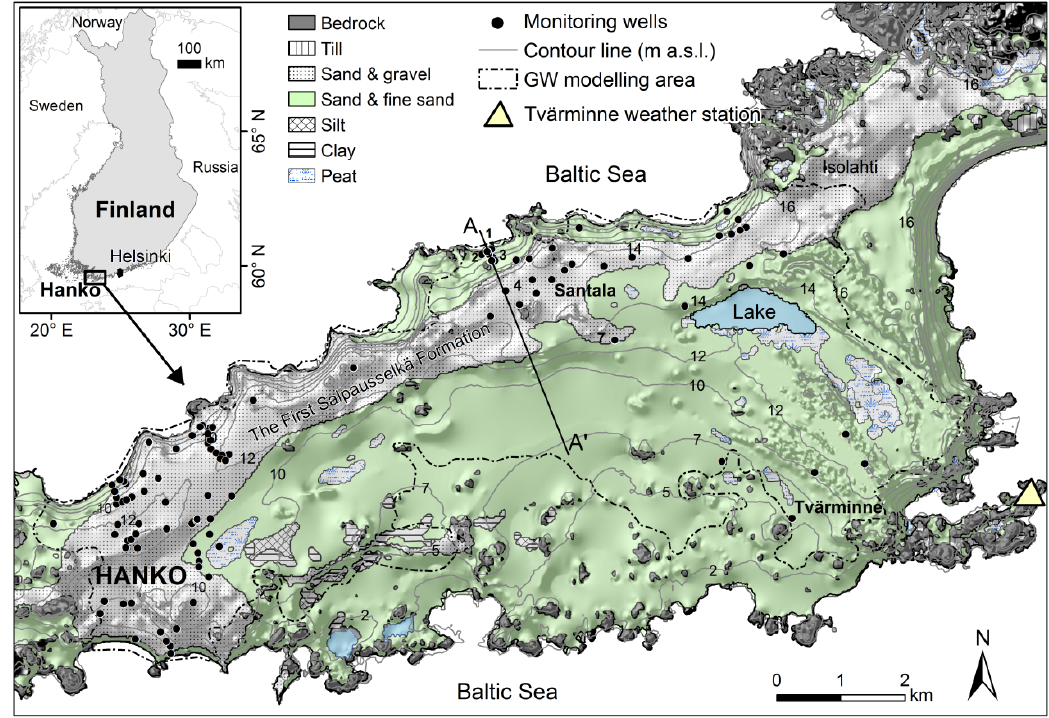
Figure 1. Location and Quaternary deposit map of the study area. A cross-section along line A-A' is presented in Figure 2. Contour line labels indicate meters above mean sea level (m a.s.l.).